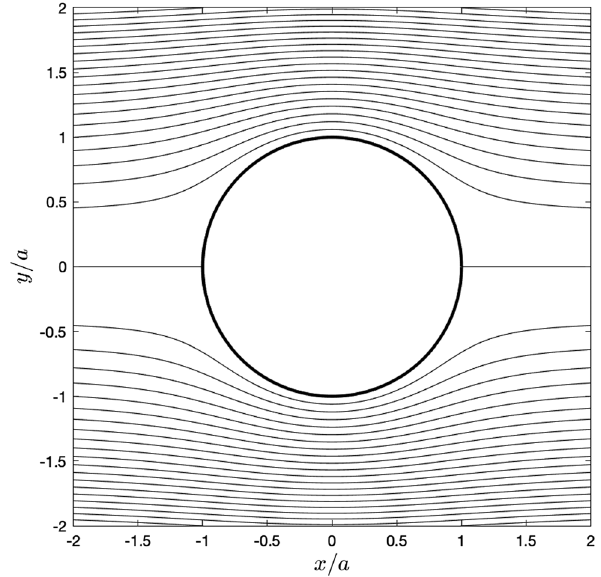
FIG. 4. Streamlines of the ideal flow around a